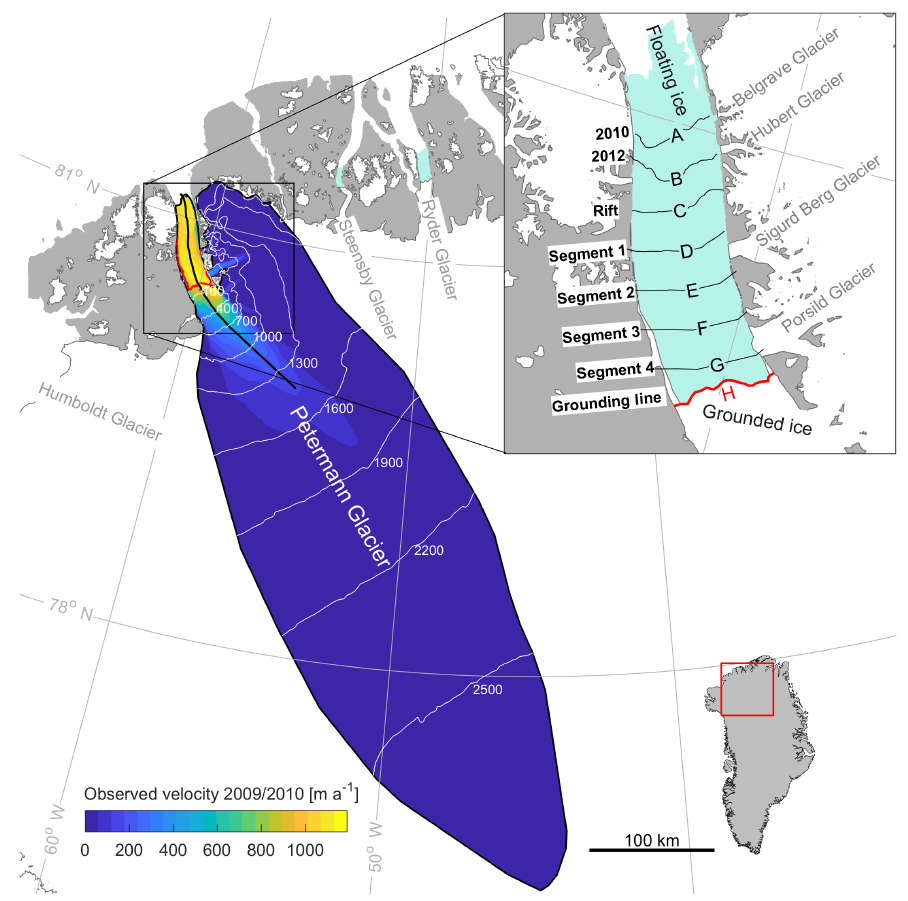
Figure 1. Study location, Petermann Glacier, northwest Greenland. Observed ice speeds from the MEaSUREs program (winter 2009/2010, Joughin et al., 2010) across the Petermann Glacier catchment, which corresponds with our model domain. White lines show 300m ice surface contours across the catchment. The thick black line is the glacier centerline and the thick red line is the glacier grounding line. Inset shows the location of newly prescribed terminus positions for each diagnostic perturbation experiment (A–H). Light turquoise shows floating ice, and white is grounded